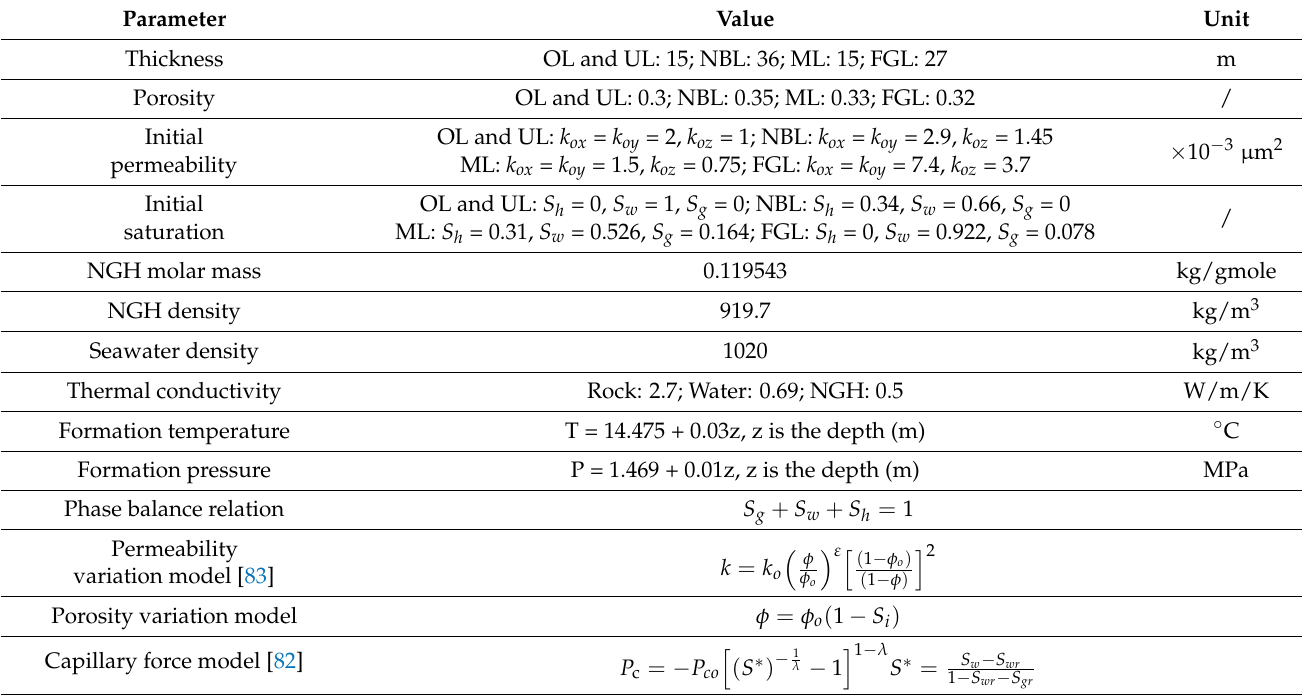
Figure 5. Schematic diagram of the exploitation model. Table 1. Main parameters of the reservoir model.